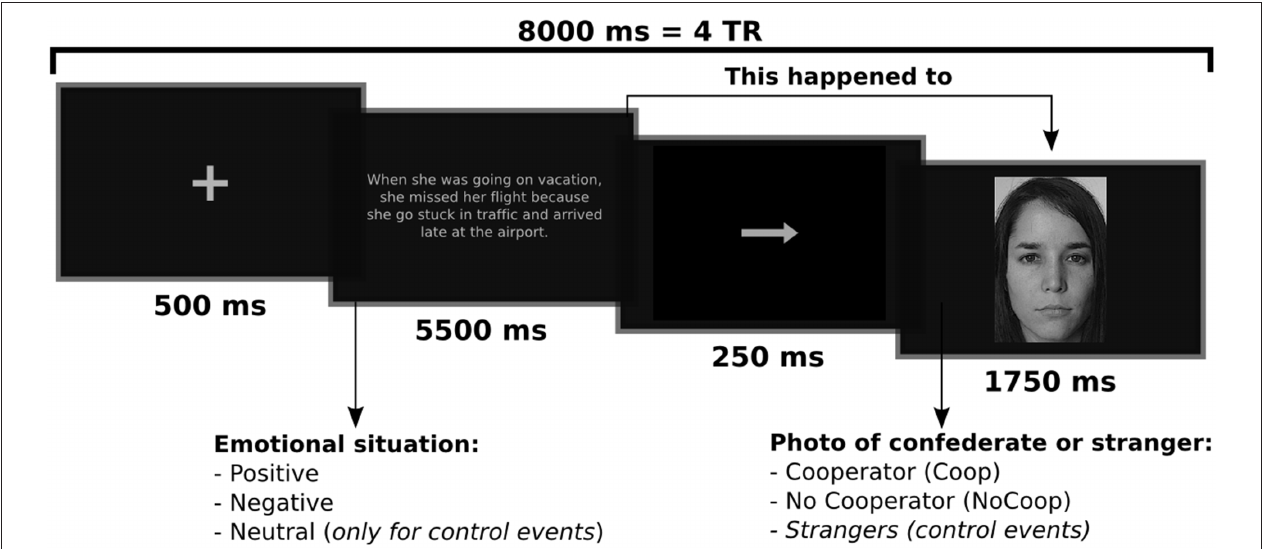
FIGURE 2 | Example of an experimental trial or event. Participants read an emotional situation in a text for 5.5 s followed by an arrow for 0.25 s which indicated that this emotional situation happened to people who appeared in the next slide for 1.75 s The interval between trials (fixations) was 0.5 s. Written and